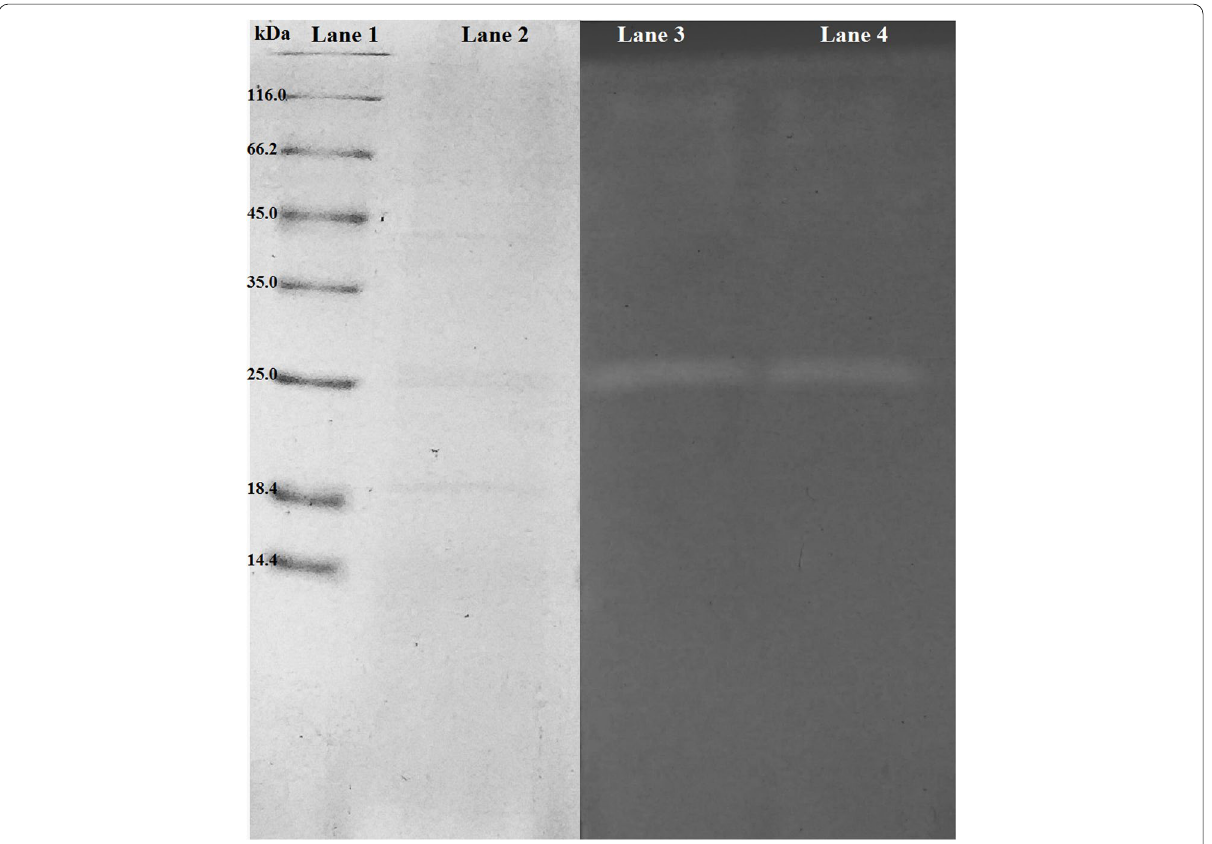
Fig. 5 SDS‑PAGE and zymogram analysis of keratinase produced by Pedobacter sp. 3.14.7; lane 1: standard pattern of protein markers (kDa, Thermo Scientific ™ Pierce ™ Unstained Protein 26610); lane 2: protein pattern of crude keratinase; lanes 3 and 4: zymogram staining of the keratinase